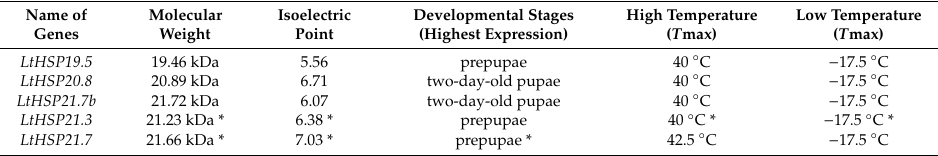
Figure 2. Structure of sHSPs. ( A ) The domain organization of sHSPs: N-terminal region (blue), α -crystallin domain (turquoise), and the C-terminal region (red); ( B – D ) protein tertiary structure of LtHSP19.5 ( B ); LtHSP20.8 ( C ); and LtHSP21.7b ( D ). Table 1. The Characteristics of Five sHSPs in L. trifolii.